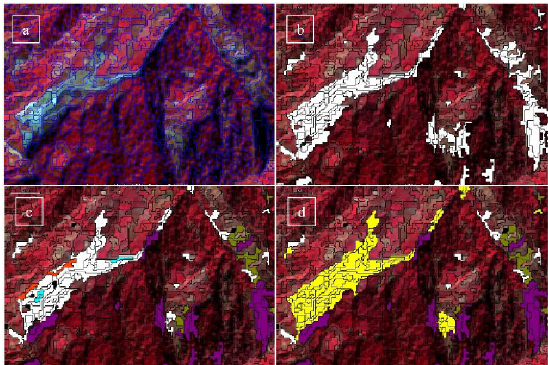
Figure 4. Subset of images representing segmentation process, a) multiresolution segmentation, b) selection of potential landslides (in white), c) removal of false positives, and d) final selection of landslide (in yellow) After the removal of most false positives, remaining potential landslides with NDVI <0.3 and mean slope >15 were taken as final landslides. These landslides were merged with surrounding objects when they were sharing >0.5 of their border. Also, some random pixels within the landslides were merged. Figure 5 represents selected landslides along with removed false positives. Finally, selected landslides were exported as shape-files to be used in accuracy assessment.